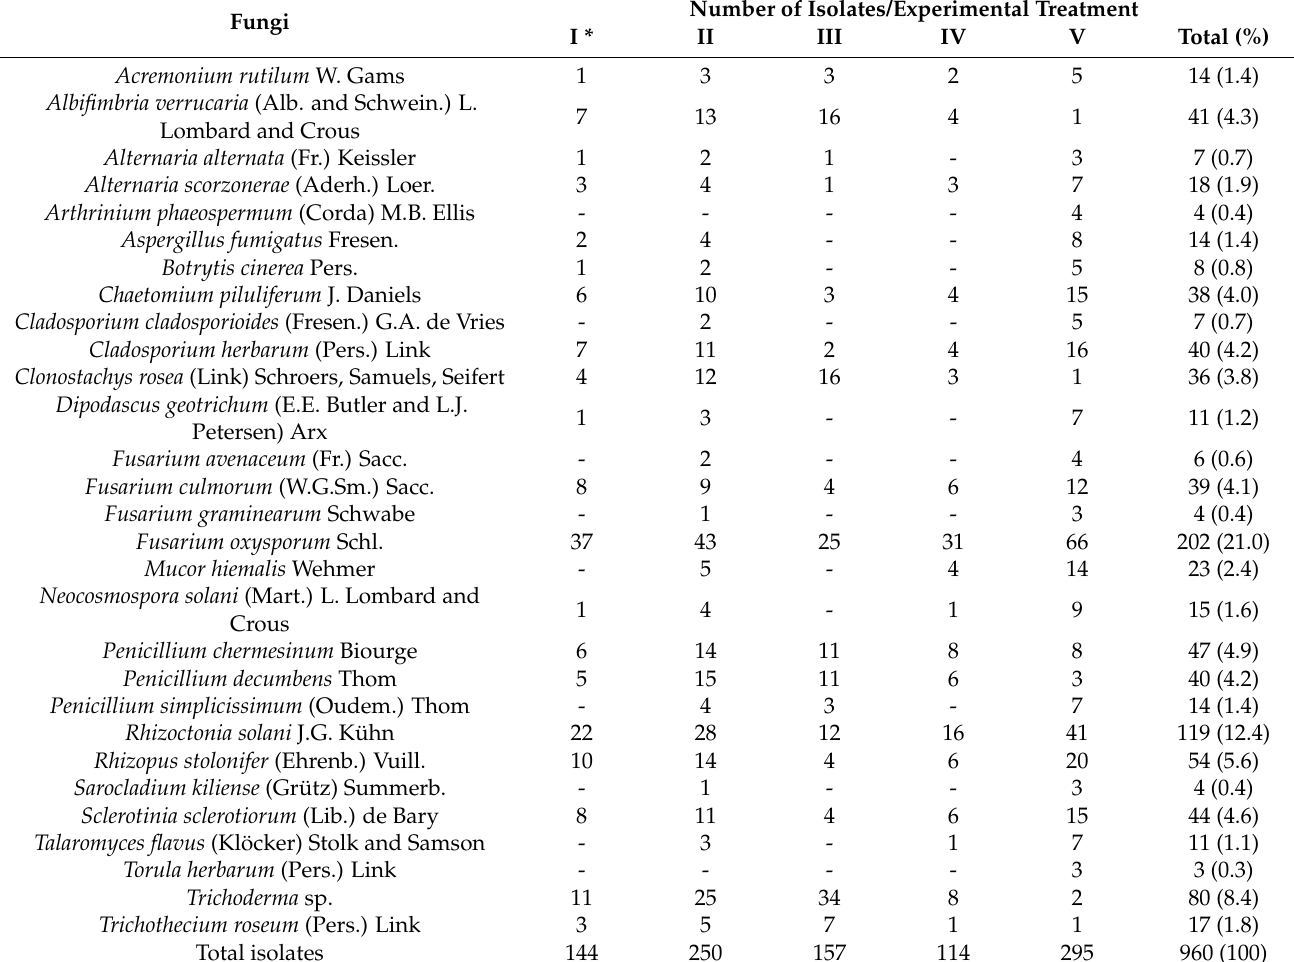
Table 5. Fungi isolated from the rhizosphere of scorzonera (sum 2014–2016).